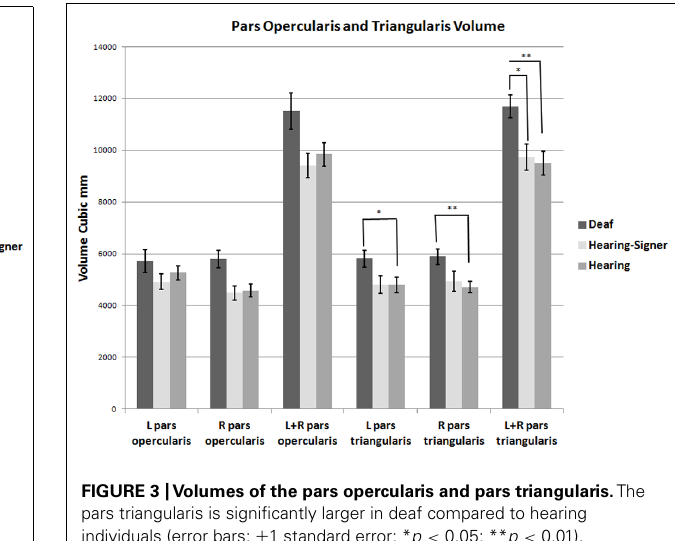
FIGURE 3 |Volumes of the pars opercularis and pars triangularis. The pars triangularis is significantly larger in deaf compared to hearing individuals (error bars: ± 1 standard error; * p < 0.05; ** p <